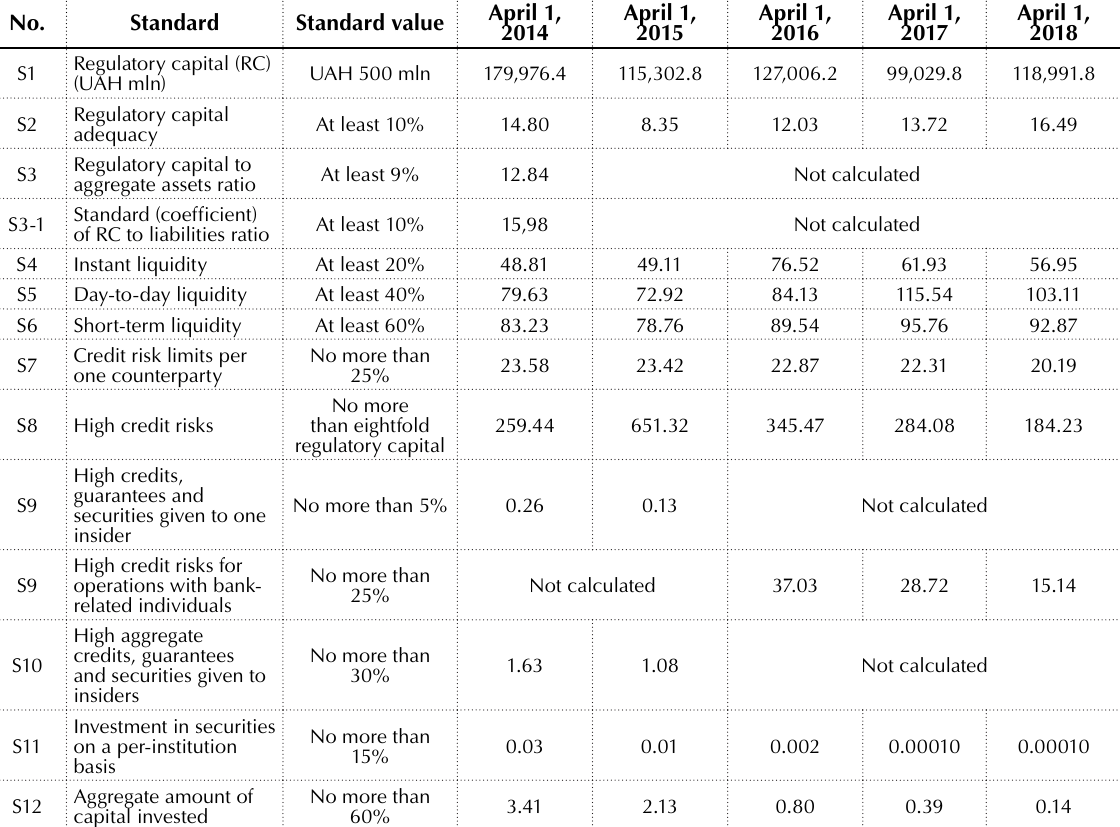
Table 3. Indicators of economic standards as of April 1, 2015 – April 1, 2018